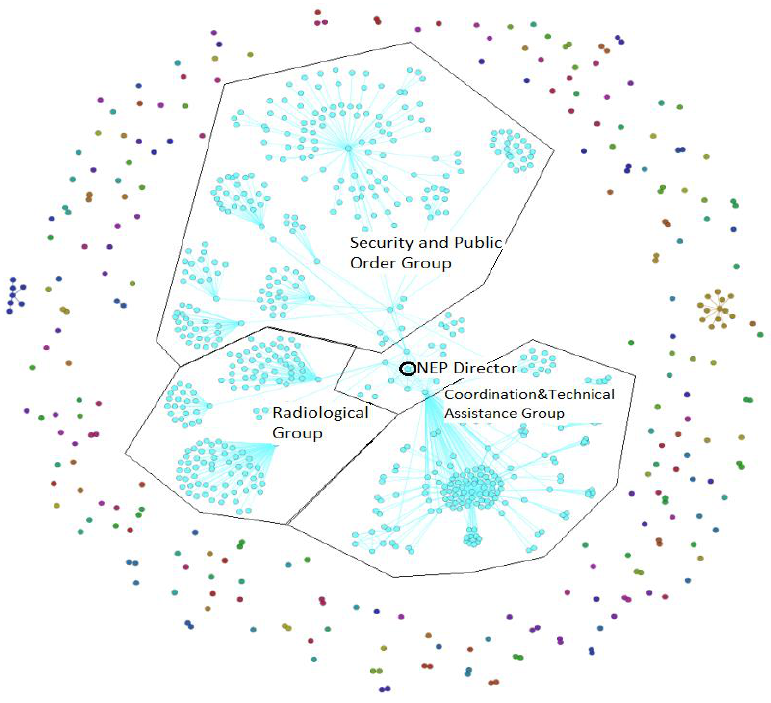
Figure 3. Collapse in the phone communication channel. Scenario 1. Case